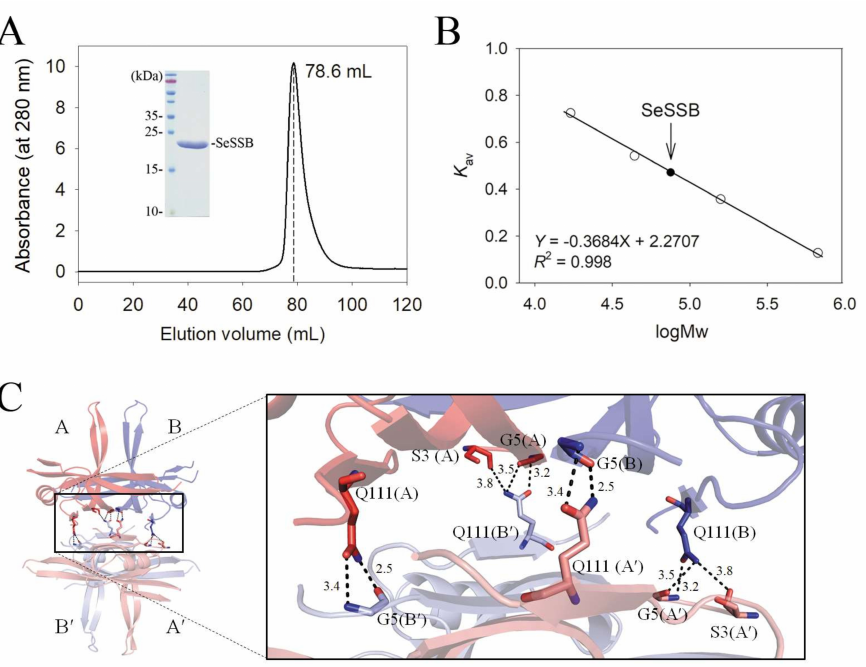
Figure 2. Oligomeric state of SeSSB. ( A ) Gel-filtration chromatographic analysis of the purified SeSSB. The corresponding single peak shows the eluting SeSSB. Coomassie Blue-stained SDS-PAGE (15%)